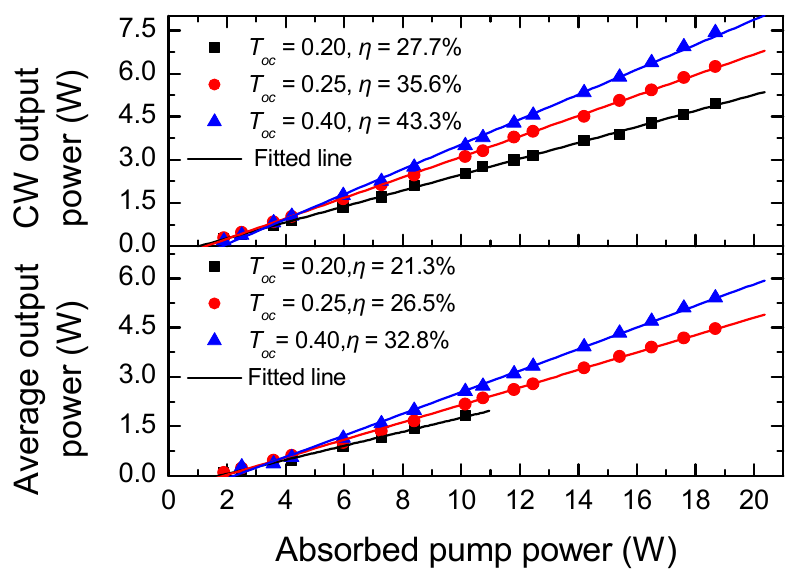
Figure 2. Output power of CW and PQS lasers vs. absorbed pump power.